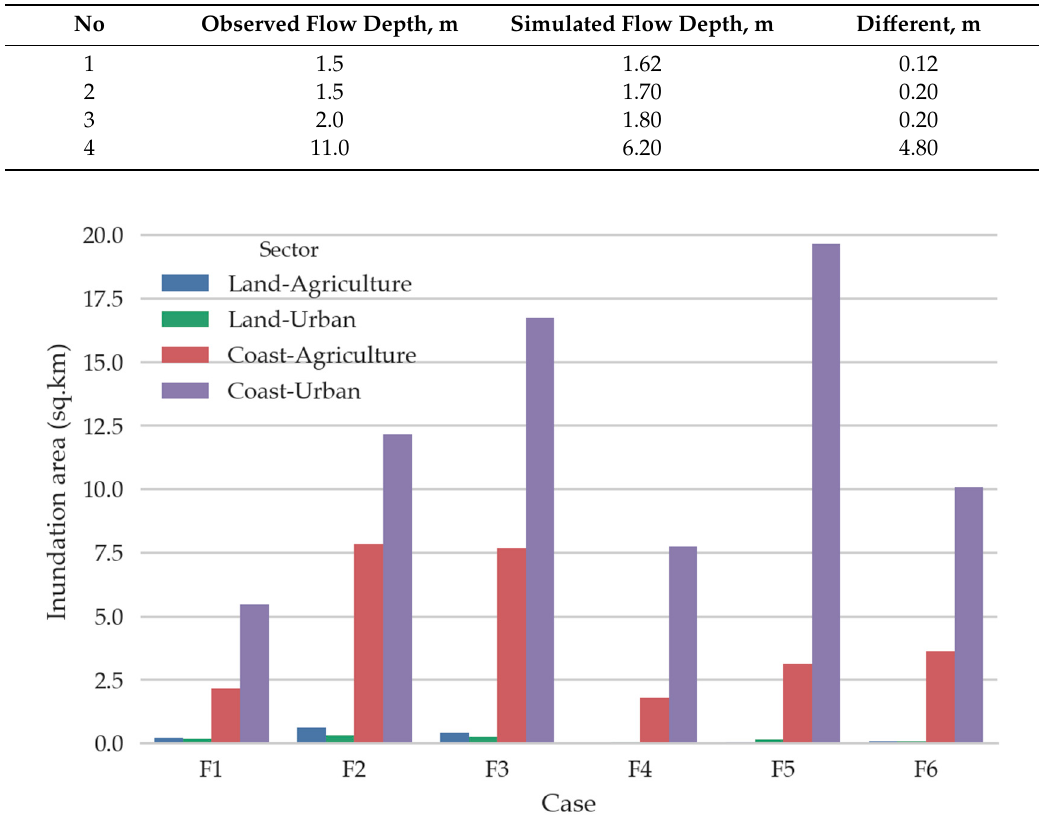
Figure 9. Inundation area presented for the economic sector in each tsunami case. Table 3. Comparison between observation data and simulation results.